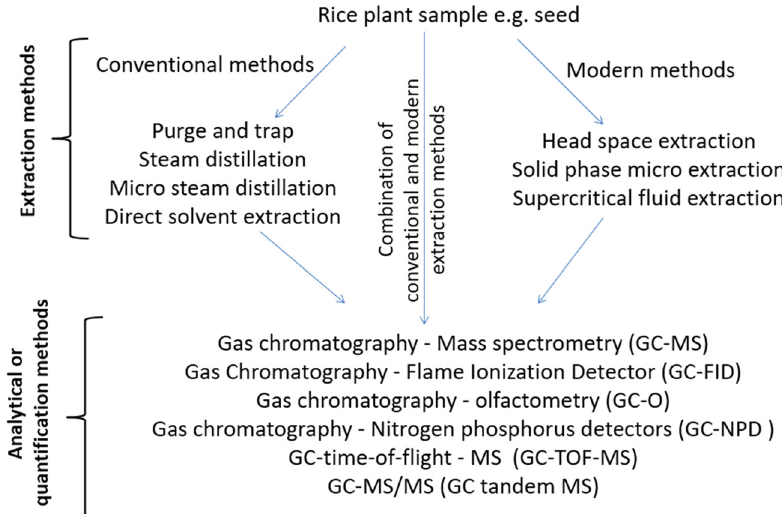
Figure 2: Methods for extraction and quanti fi cation of aroma in